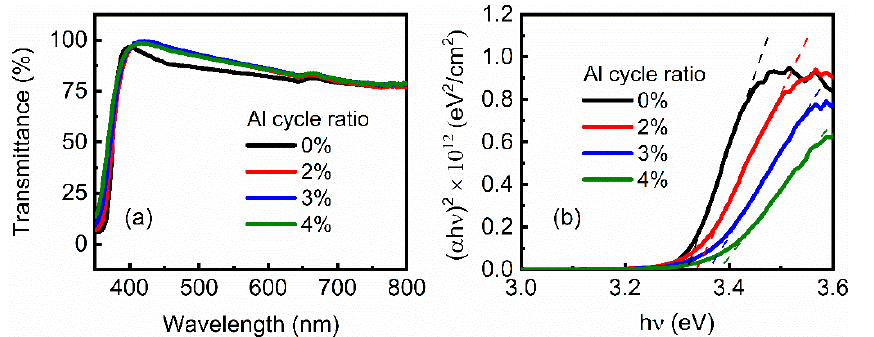
Figure 3. ( a ) Transmittance of ZnO and AZO films. ( b ) ( α h ν ) 2 -h ν curve of ZnO and AZO films. ZnO and AZO films were deposited on glass substrates.